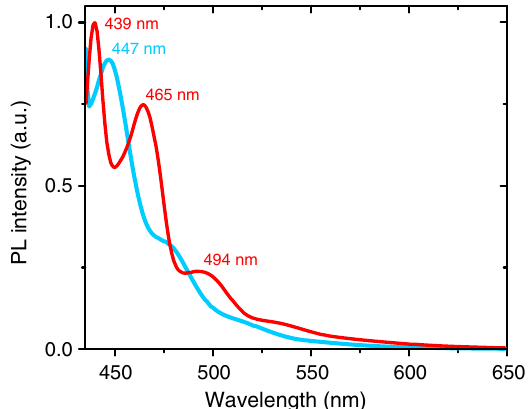
FIG. 19. PL spectra of thick ( ∼ 1 . 8 μ m) glassy (blue line) and β -phase (red line) PFO films, as used for TOF measurements, recorded with excitation at 432 nm. This excitation wavelength closely matches the S 0 -S 1 0-0 absorption peak of the β -phase (see Fig. 18) and will therefore select sites containing β -phase segments. Such site-selective excitation populates any β -phase chain segments directly, in contrast to excitation at shorter wavelengths that would populate β -phase segments via exciton energy transfer. This method is thus a more sensitive spectro- scopic probe of the presence of β -phase, and the absence of emission characteristic of β -phase for the glassy film confirms that the glassy PFO films are indeed maximally free from β -phase. The wavelengths corresponding to the vibronic peaks are indicated, showing excellent agreement with the ones in Fig. 18(b), and with previously published spectroscopic data for glassy and β -phase PFO